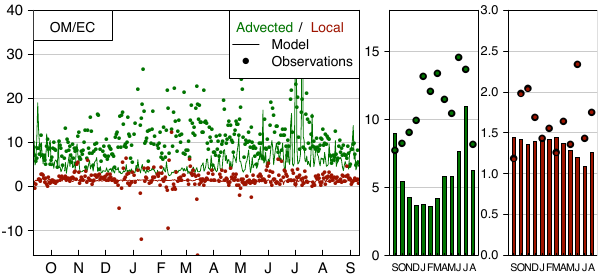
Figure 12. Local OM / EC ratio (unitless) time series (left) and monthly averages (right) for model (line and bars) and observations